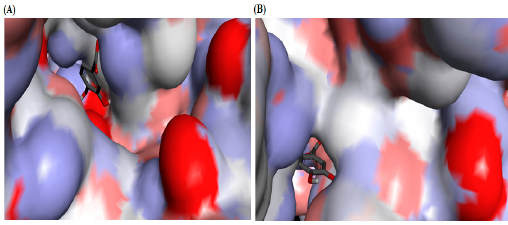
Figure 5. Surface representation of the active-site flap of urease with protocatechuic acid (PCA), shown at the entrance of the binding pocket. ( A ) Jack bean urease (JBU; PDB code: 3LA4); ( B ) Helicobacter pylori urease (HPU; PDB code: 1E9Y).